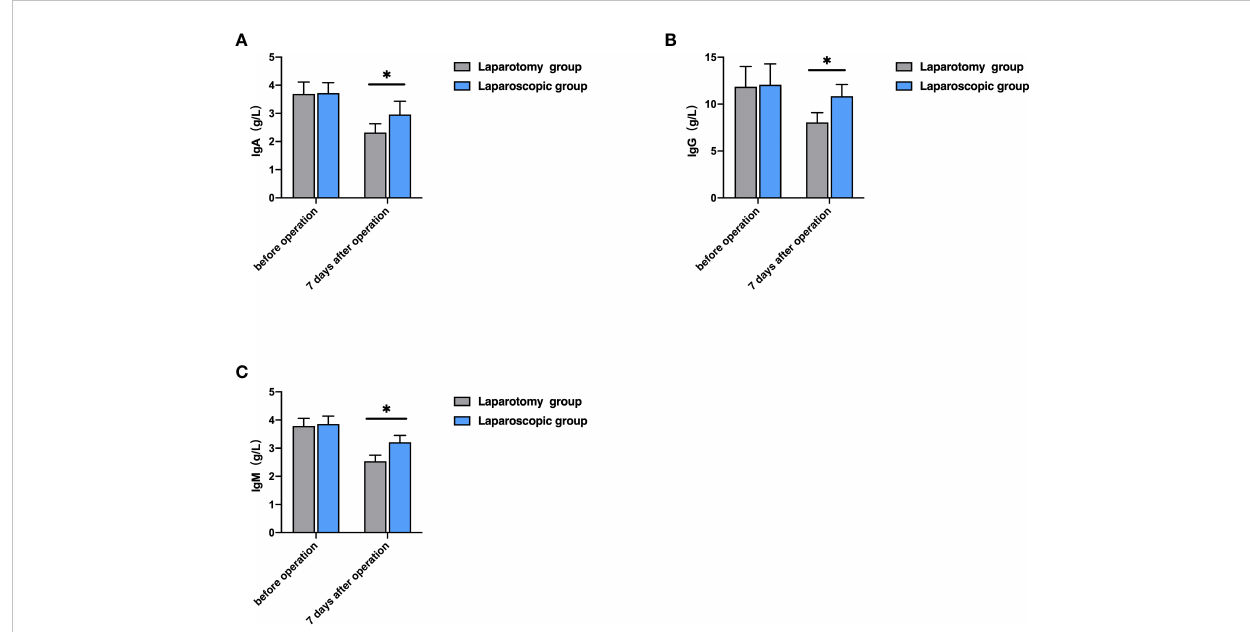
FIGURE 2 Comparison of immune function indexes between the two groups. (A) Comparison of IgA level; (B) Comparison of IgG level; (C) Comparison of IgM level; * P